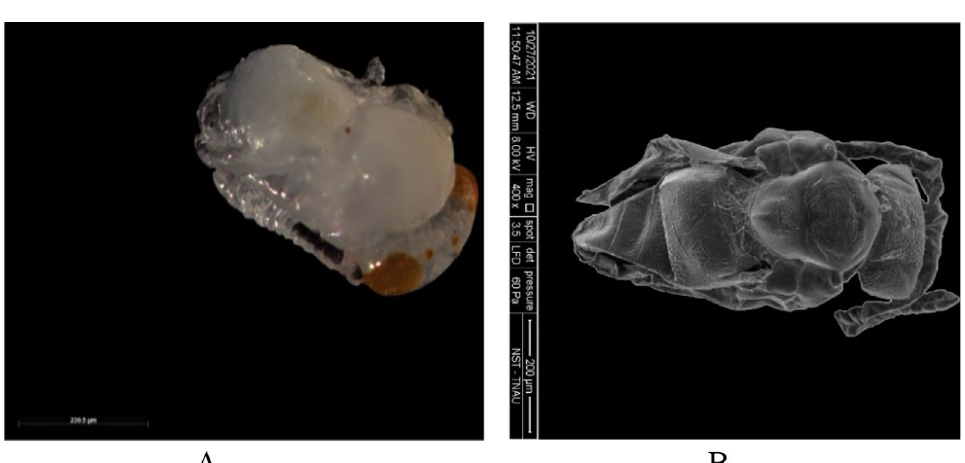
Fig. 9 A, B Third pupal phase of T.